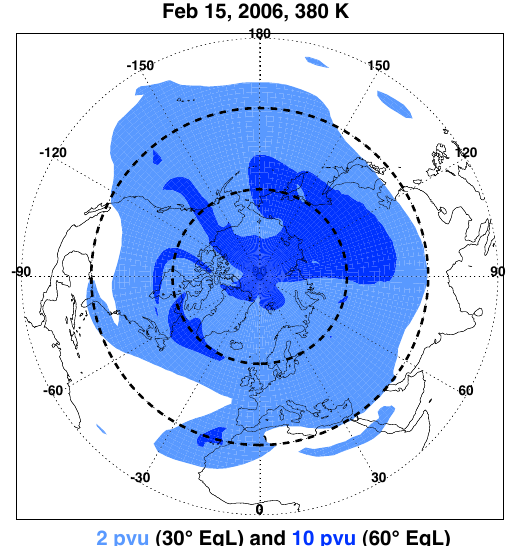
Fig. 1. In this example, contours of 30 ◦ and 60 ◦ EqLat are shown on the 380K potential temperature surface for the 15 February 2006 00:00UTC WACCM analysis. These two contours correspond to PV of 2pvu and 10pvu, respectively. For contrast, the geographical latitudes of 30 ◦ and 60 ◦ (dashed circles) are also given.